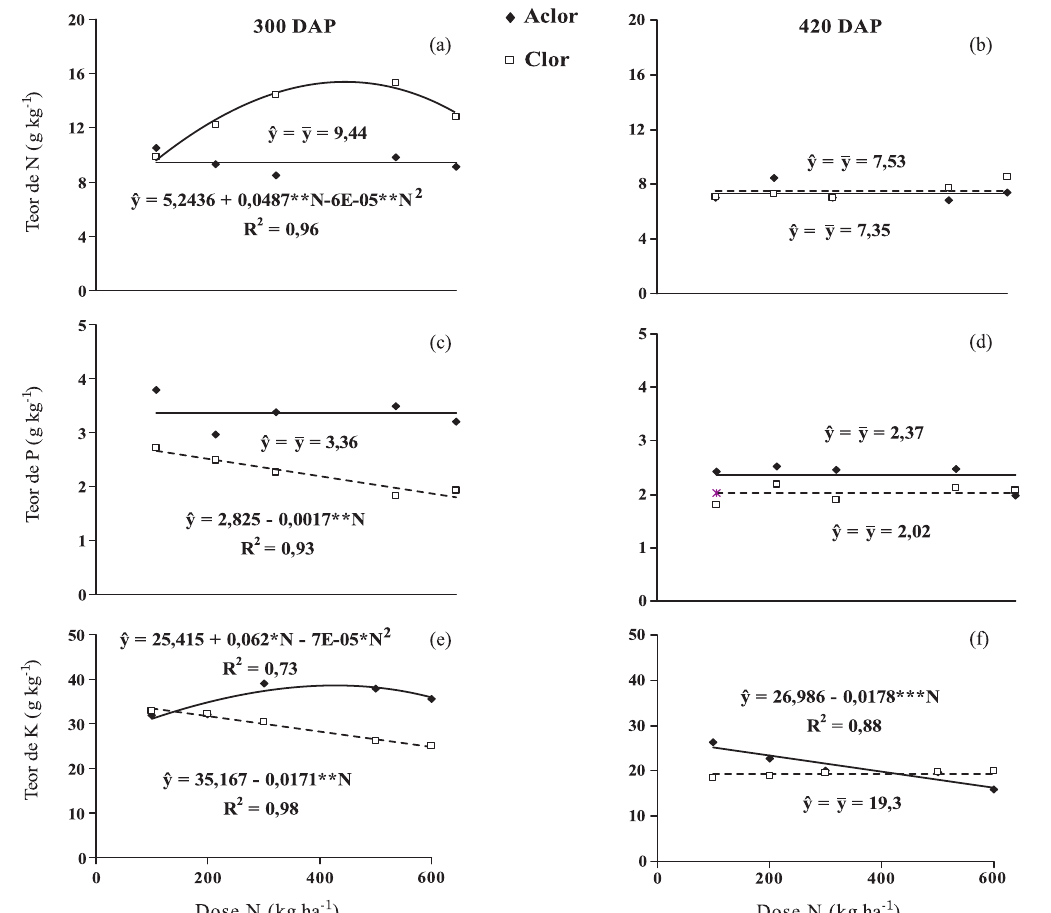
Figura 2. teores de N (a e b), p (c e d), e K (d e F) em folhas de abacaxizeiro ‘Vitória’, nas porções aclo- rofiladas e clorofiladas, aos 300 e 420 dias após o plantio (dap), em função das doses de N. *** , ** e * significativo a 0,1, 1 e 5 %, respectivamente, pelo teste